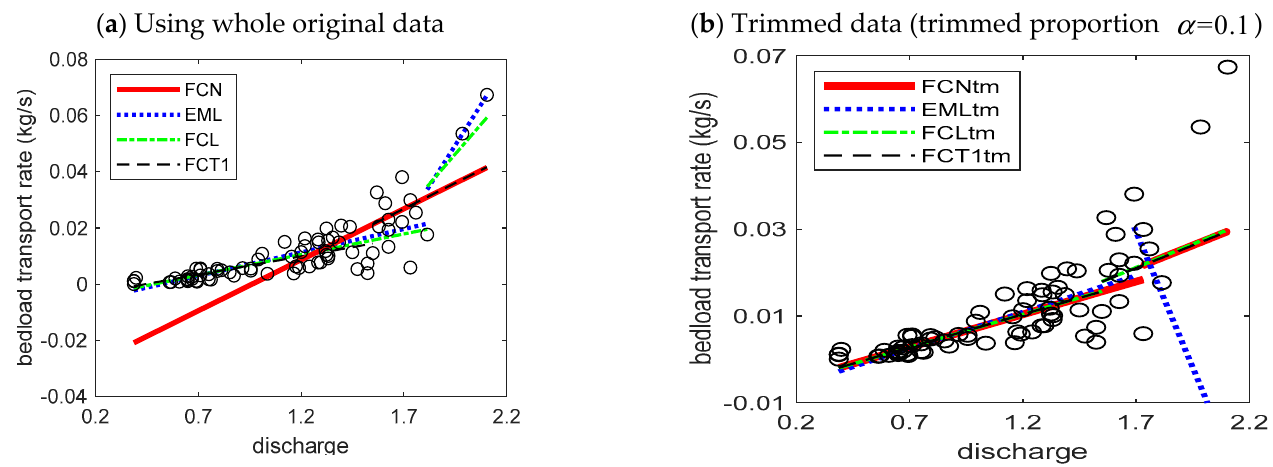
Figure 11. Fitting results of the four methods with original and trimmed data.